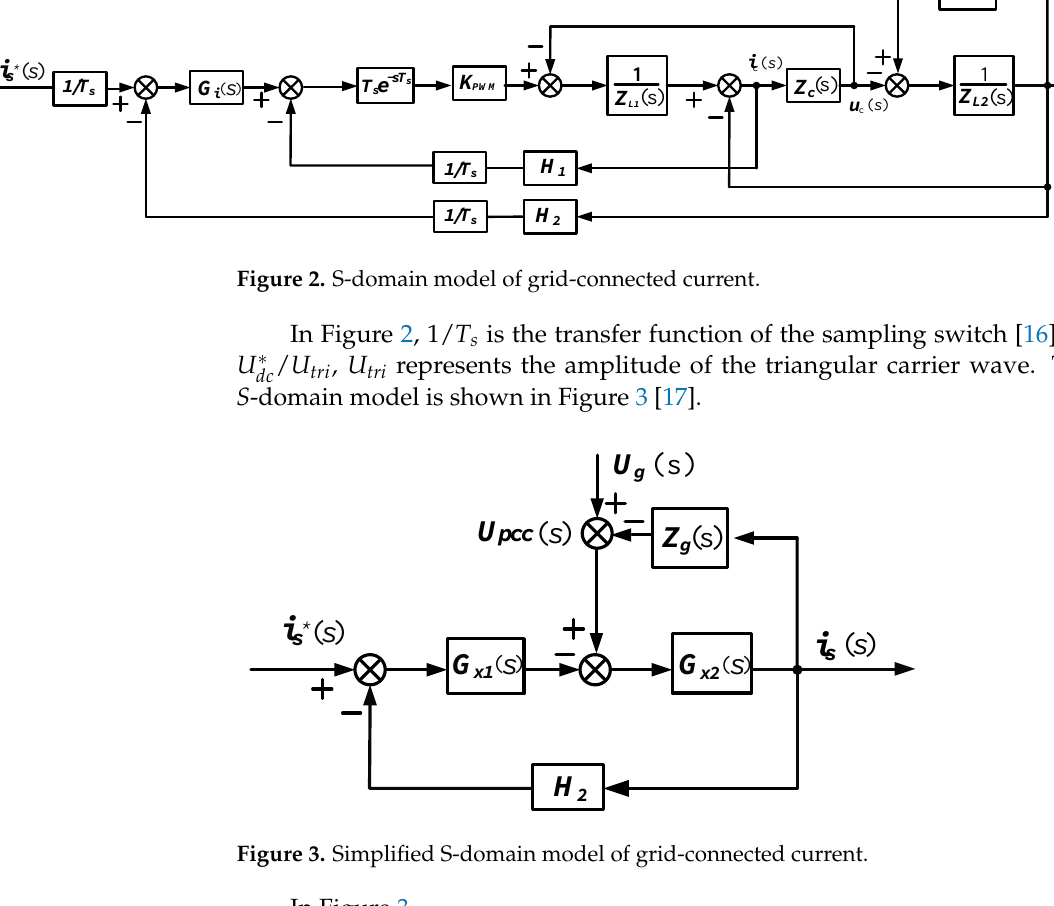
Figure 1. Structure diagram of LCL -Type grid-connected converter without PLL in weak gird conditions.